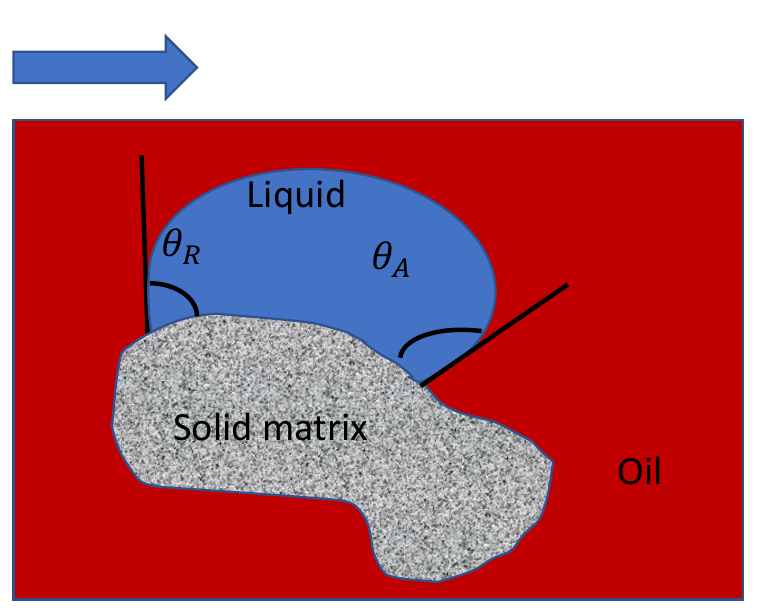
Figure 1. Schematic of advancing and receding contact angles of two-phase flow interacting with a porous solid